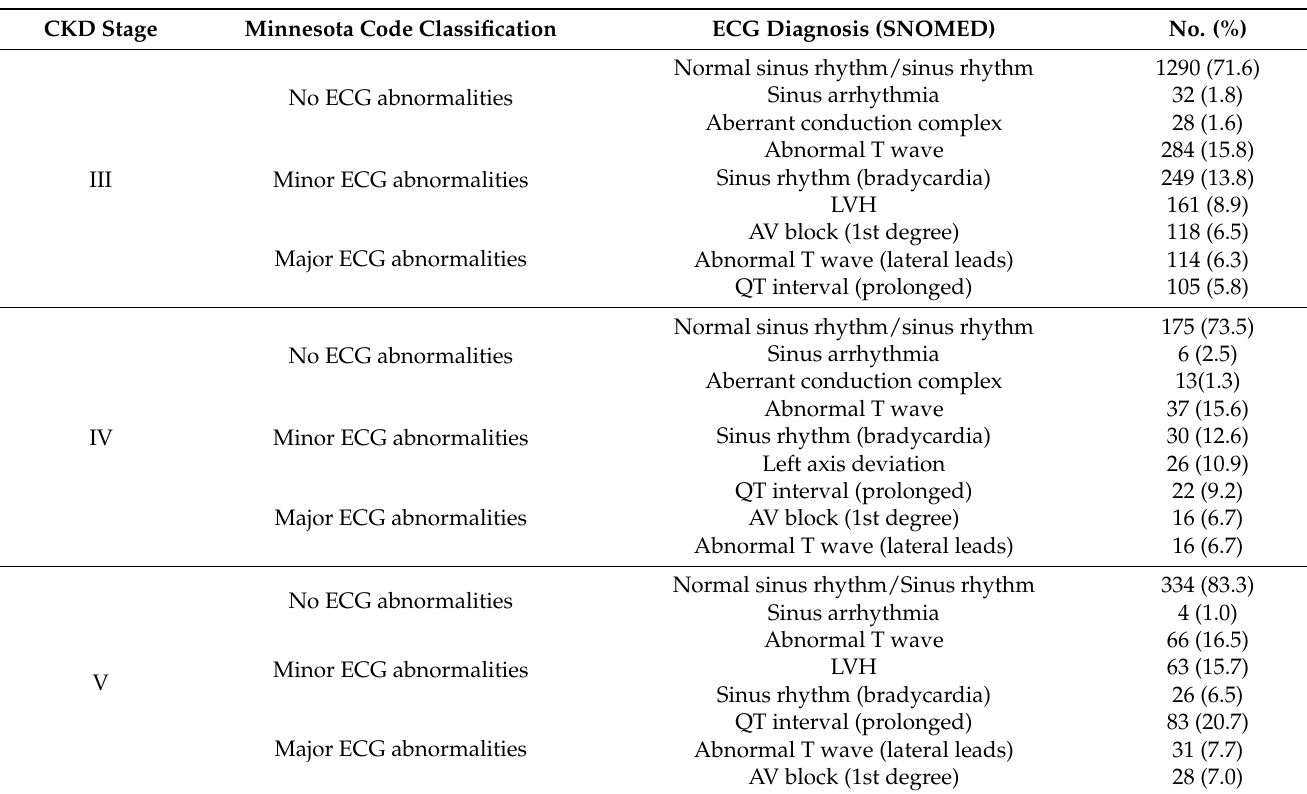
Table 2. Top 3 ECG diagnoses according to CKD stage and ECG group.